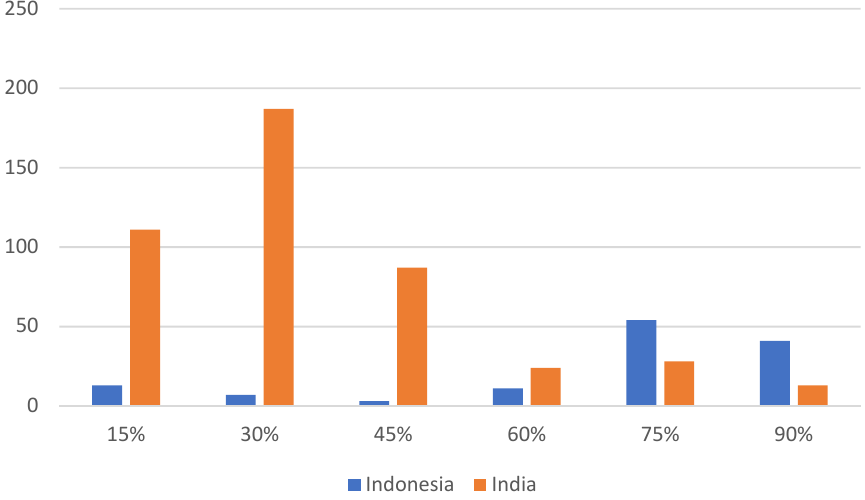
Figure 2. Results of Q10 (percentage of people who believe in the same religion in respondents’ city). Note: Sample sizes are n = 129 and 450 for Indonesia and India, respectively.